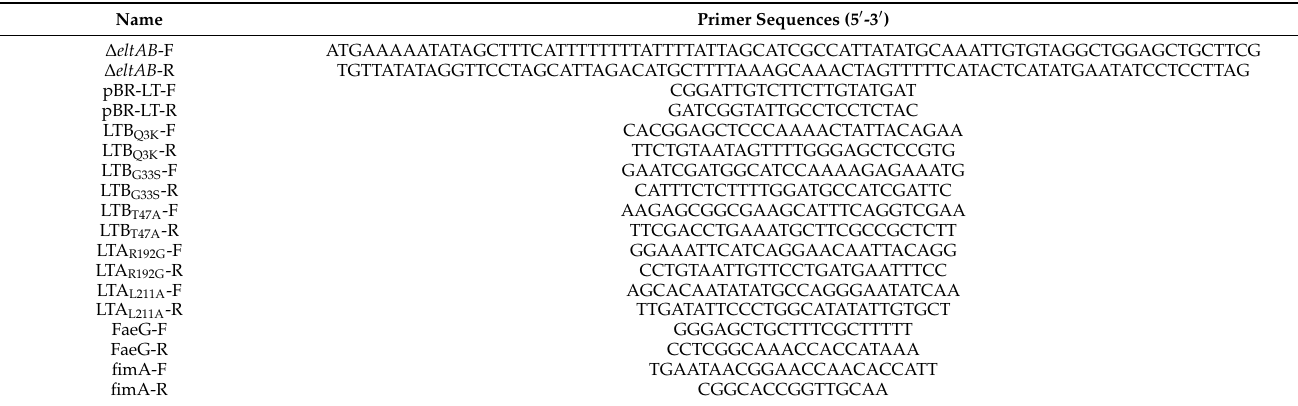
Table 2. The primer oligonucleotide sequences used in this